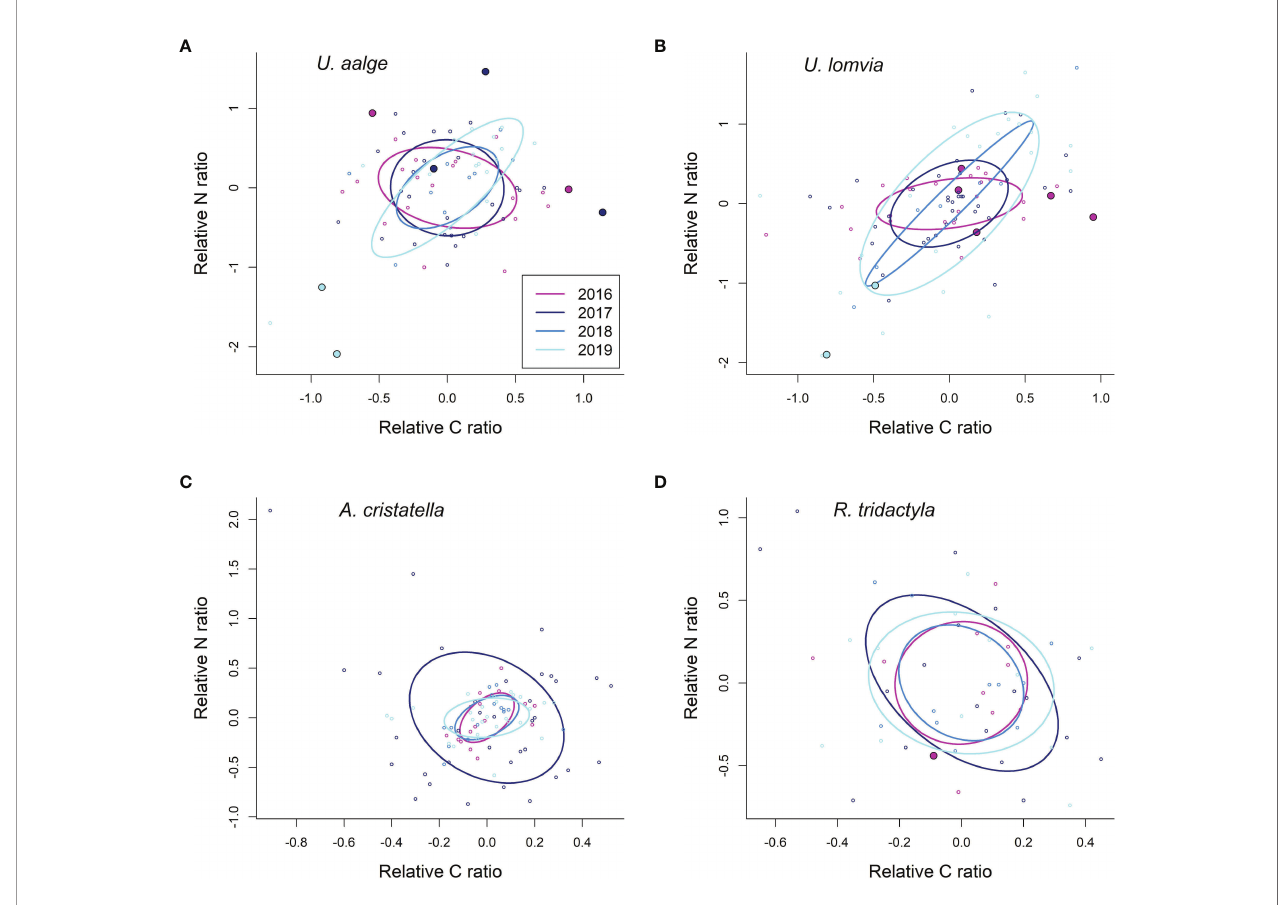
FIGURE 6 | Standard Bayesian ellipse areas (solid lines) corrected for small sample sizes ( (A) : common murres; (B) : thick-billed murres; (C) : crested auklets; (D) : black-legged kittiwake). The axes show the d 13 C and d 15 N isotopic ratios relative to the average values per species and year. Points show individual values; the larger points represent isotopic signatures of birds for which GPS data was also available (no GPS data available among crested auklets with isotopic